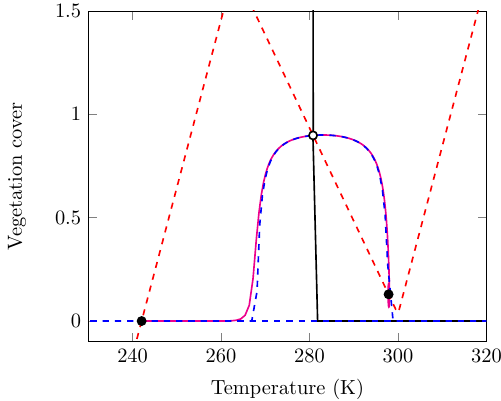
Figure 4. The ( T , A ) phase plane of the model, with the two null isoclines given by Eq. (6) (red straight line) and Eq. (7) (blue curve), respectively. The fixed points for the vegetated states of our planet are the intersections of these two curves. The non-vegetated fixed point for A (cid:54)= 0 does not appear in this plot.